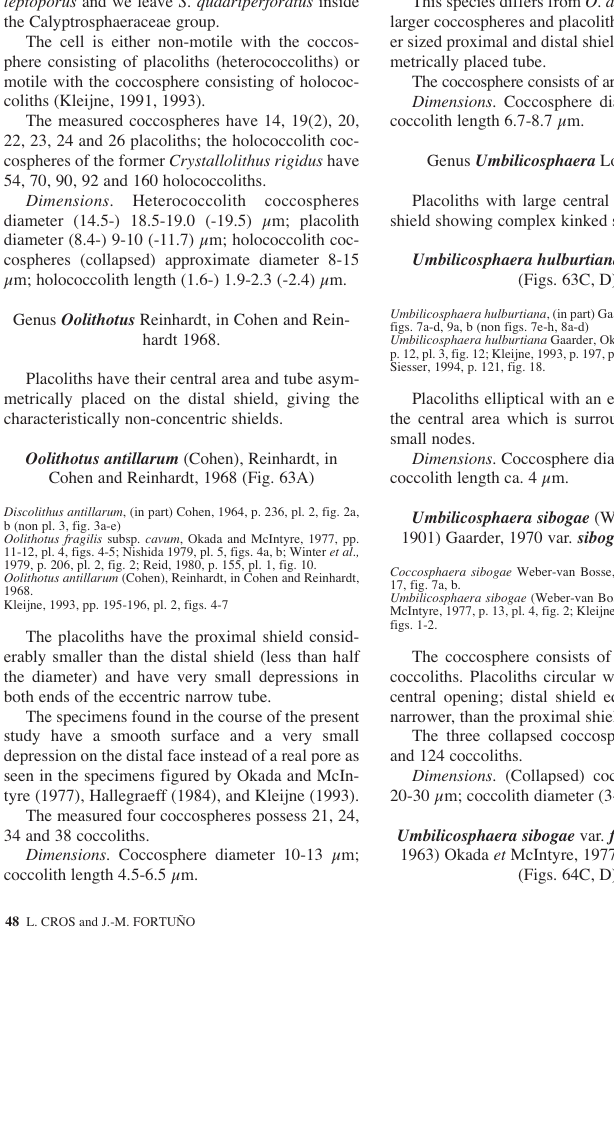
fig. 3; Borsetti and Cati, 1979, p. 159, pl. 14, figs. 5-6. This species differs from O. antillarum in having larger coccospheres and placoliths which have clos- er sized proximal and distal shields and a less asym- metrically placed tube. The coccosphere consists of around 30 coccoliths. Dimensions . Coccosphere diameter ca. 20 μm; coccolith length 6.7-8.7 μm.